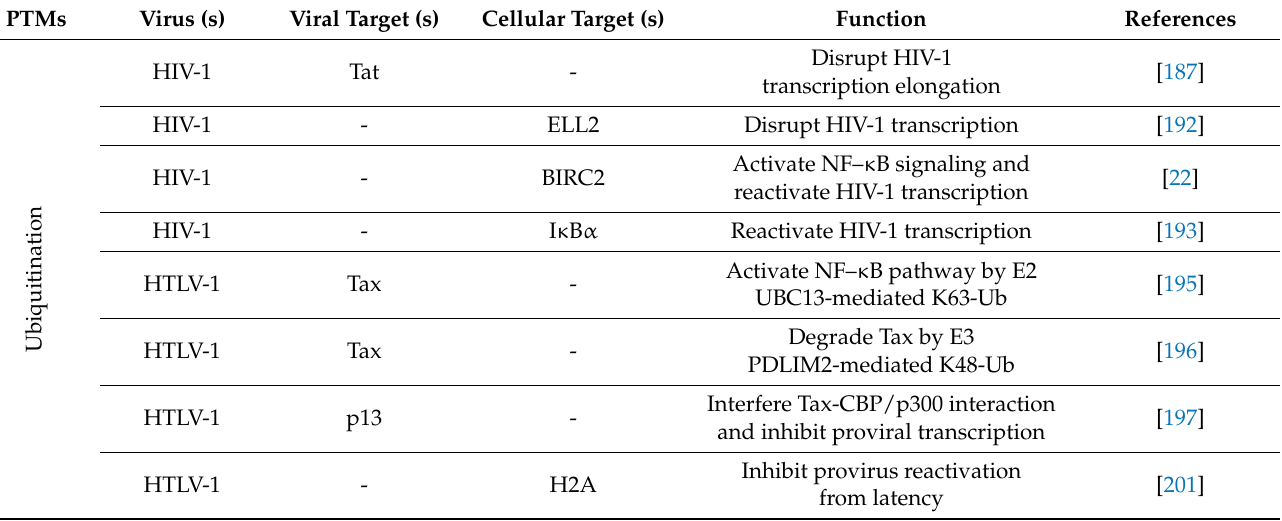
Table 2. Involvement of ubiquitination and SUMOylation of viral targets or cellular targets in retroviruses latency. The major function of PTMs of targets is also summarized. The order of these targets within the table is determined by the order that viral or cellular targets appear within the main